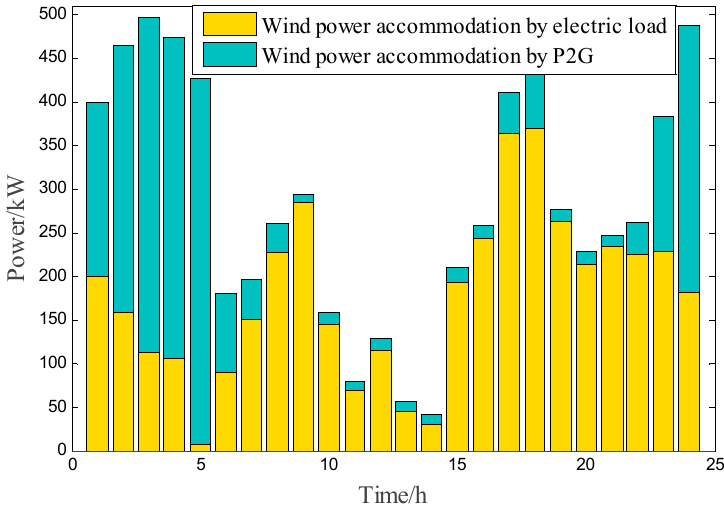
Figure 14. Overall wind power consumption of scenario 3.